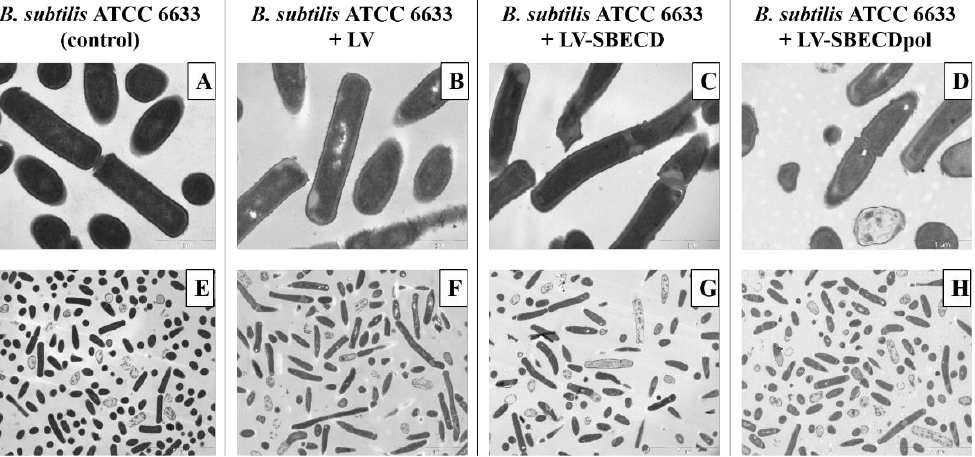
Figure 6. The TEM micrographs of B. subtilis ATCC6633: overnight culture, cells incubated with LV, LV-SBECD or LV-SBECDpol for 24 h at 37 ◦ C. C LV = 2.5 µ g/mL. Scale bar: 1 µ m ( A – D ) and 5 µ m ( E – H ).